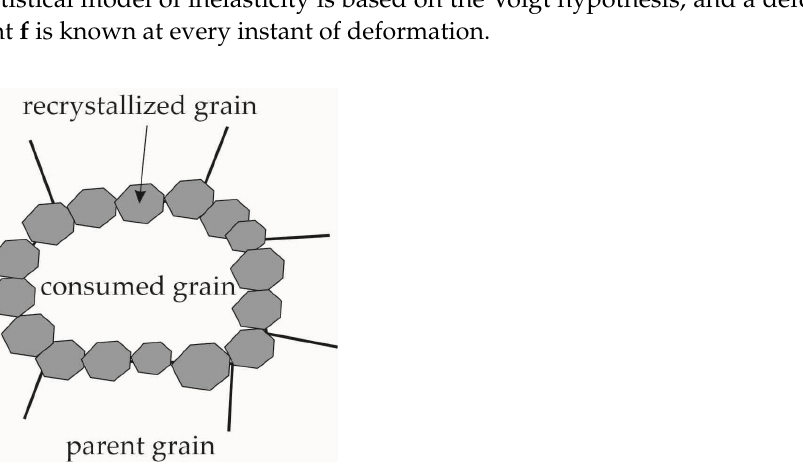
Figure 4. Scheme used for modeling a cluster of grains (a “consumed” defective grain surrounded by DRX grains).